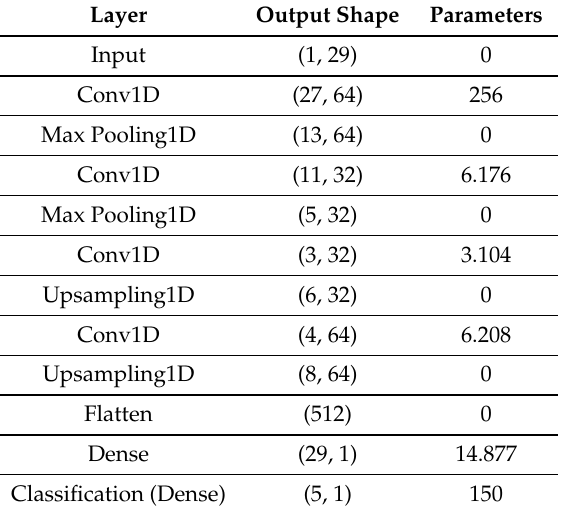
Table 4. Five-class Wind Status Classification CNN-SAE Architecture